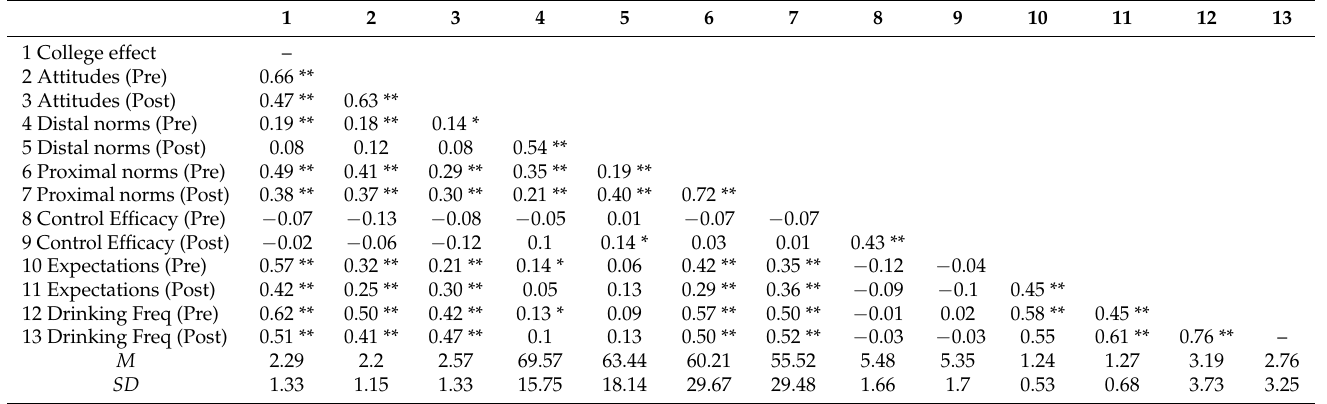
Table 1. Zero-order correlations, means and standard